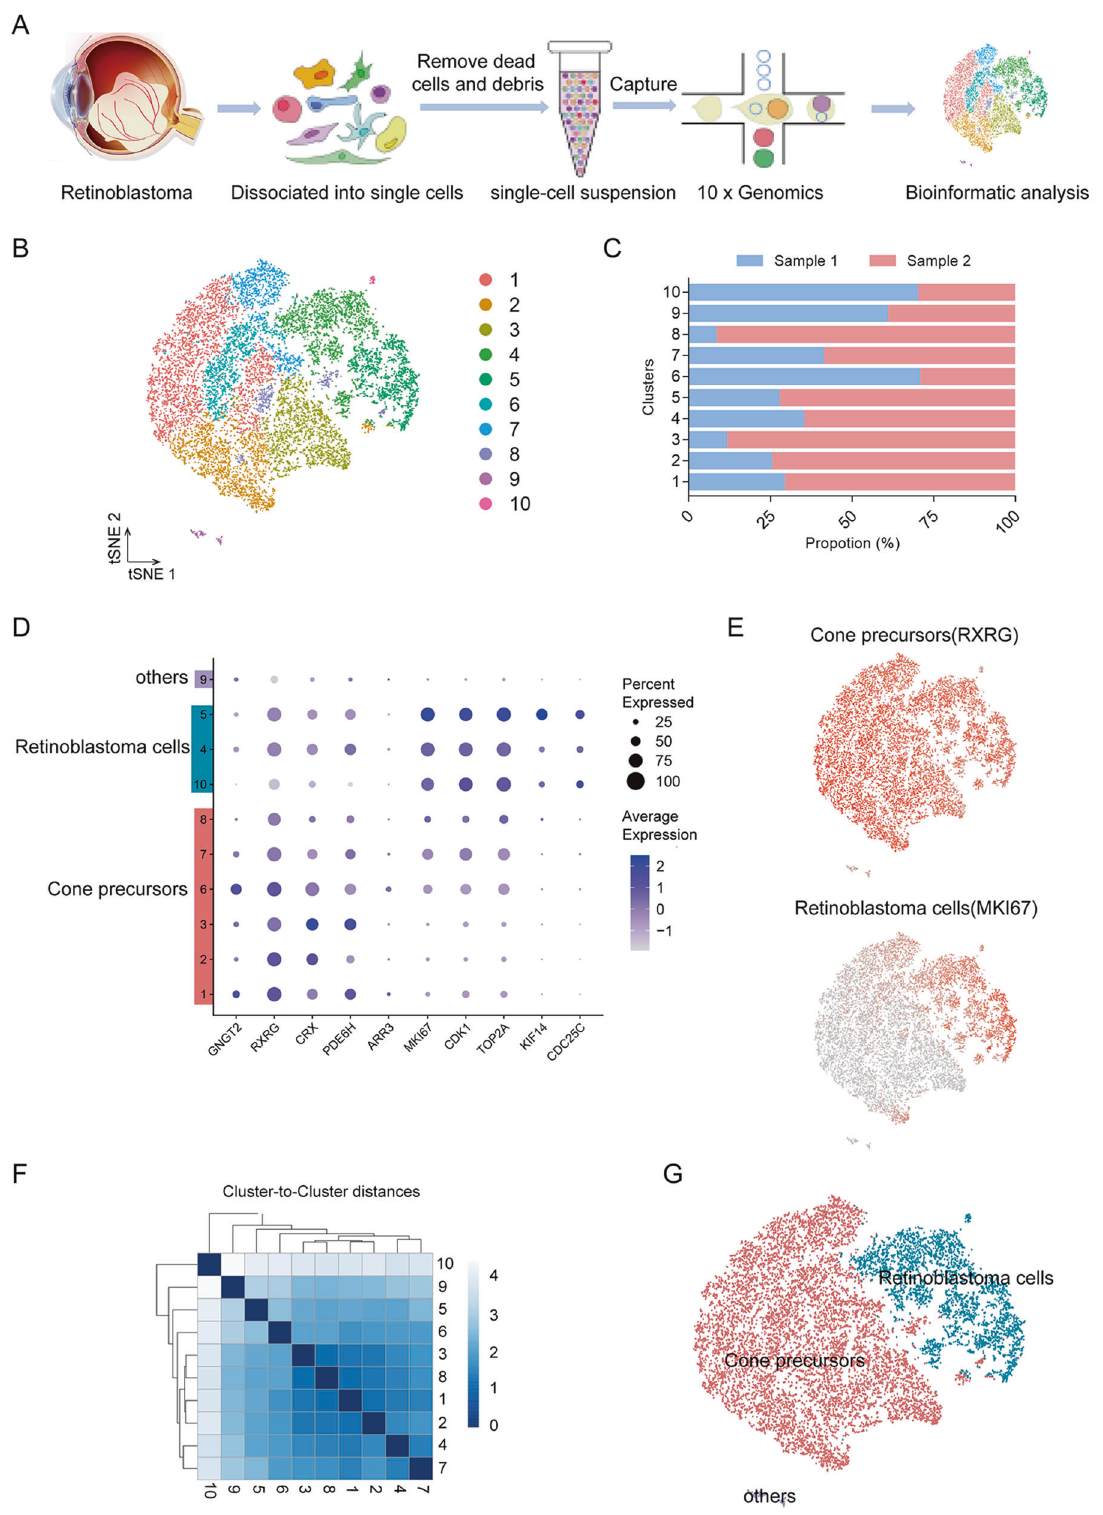
Fig. 1 scRNA-seq analysis reveals cellular heterogeneity. A Scheme of cell isolation, cell processing, capture by droplet-based device, sequencing, and downstream analysis. B t-SNE plot of single cells distributed by unbiased hierarchical clustering. C Fraction of cells in each cell cluster. D Feature expression heatmap showing expression patterns of major retinal class markers across 10 cell clusters. In a given cell identify, the sizes of circles indicate percentage of the cells expressing each marker gene; The shades of blue indicate average expression of each gene. E t-SNE plots showing expression of a set of selected marker genes for major retinal classes. F Correlation matrix for the hierarchical clusters. G t-SNE visualization of 14,739 cells pro fi led, with cells colour-coded according to cell type annotation.